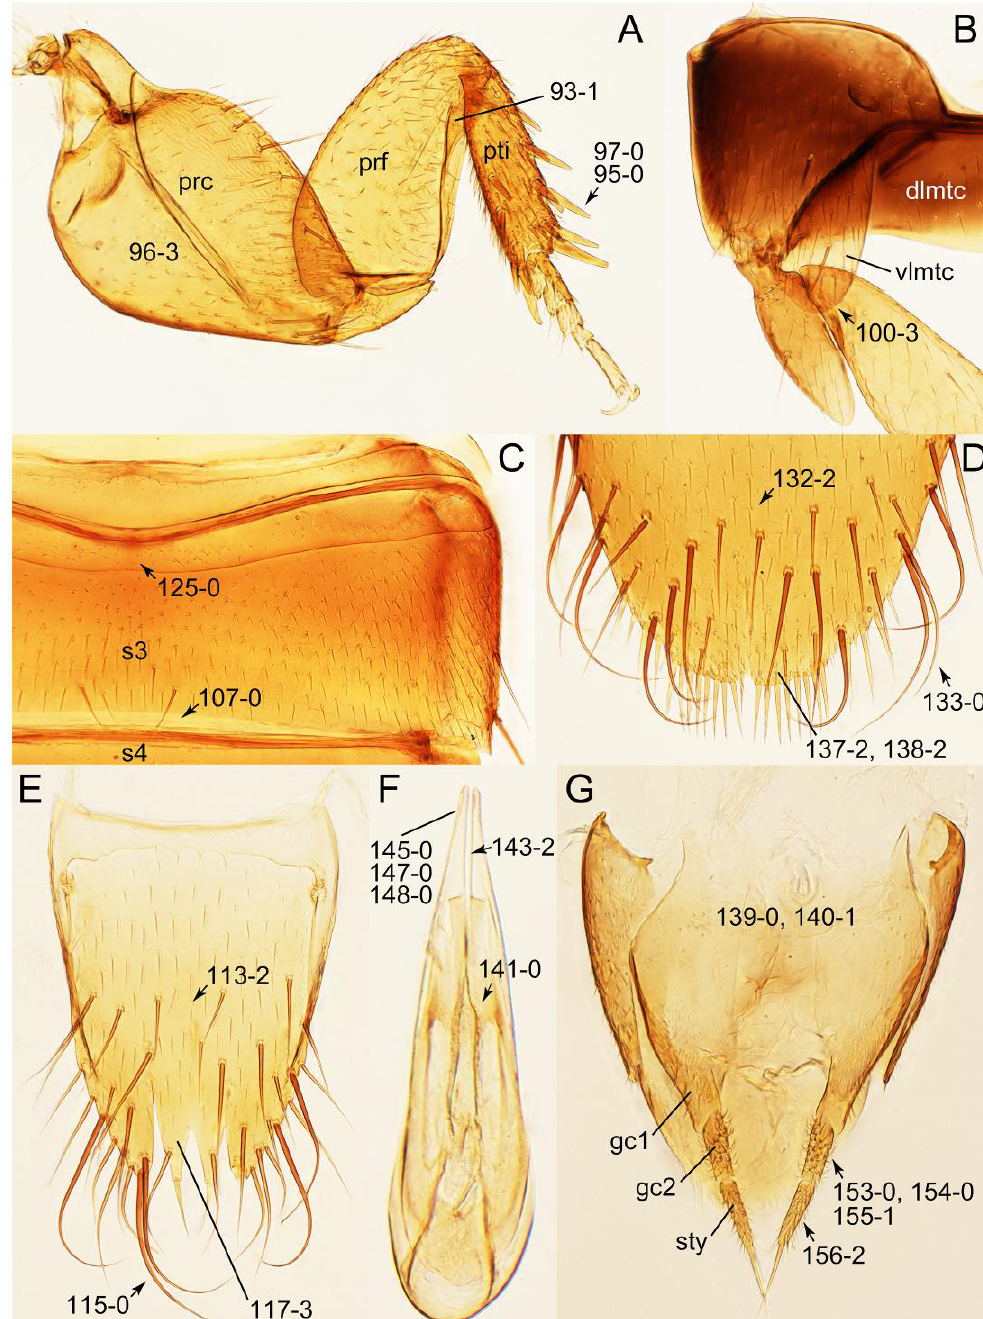
Figure 12. Photographs of body parts of Tachyporini: Tachyporina, enlarged. ( A ) left foreleg of Lamprinus erythropterus , ventral view. ( B ) left metacoxa of Tachyporus chrysomelinus , ventral view. ( C ) sternite III of Lamprinodes saginatus , ventral view. ( D ) female sternite VIII of Lamprinodes saginatus , ventral view. ( E ) female tergite VIII of Lamprinodes saginatus , dorsal view. ( F ) male aedeagus of Palporus nitidulus , dorsal view. ( G ) female genital segments of Lamprinodes saginatus , ventral view. Abbreviations: dlmtc, dorsal lamella of metacoxa; gc1–2, gonocoxite 1–2; prc, procoxa; prf, profemur; pti, protibia; s3–4, sternite III–IV; sty, gonostylus; vlmtc, ventral lamella of metacoxa. Characters and character states (format X-X) are indicated on each